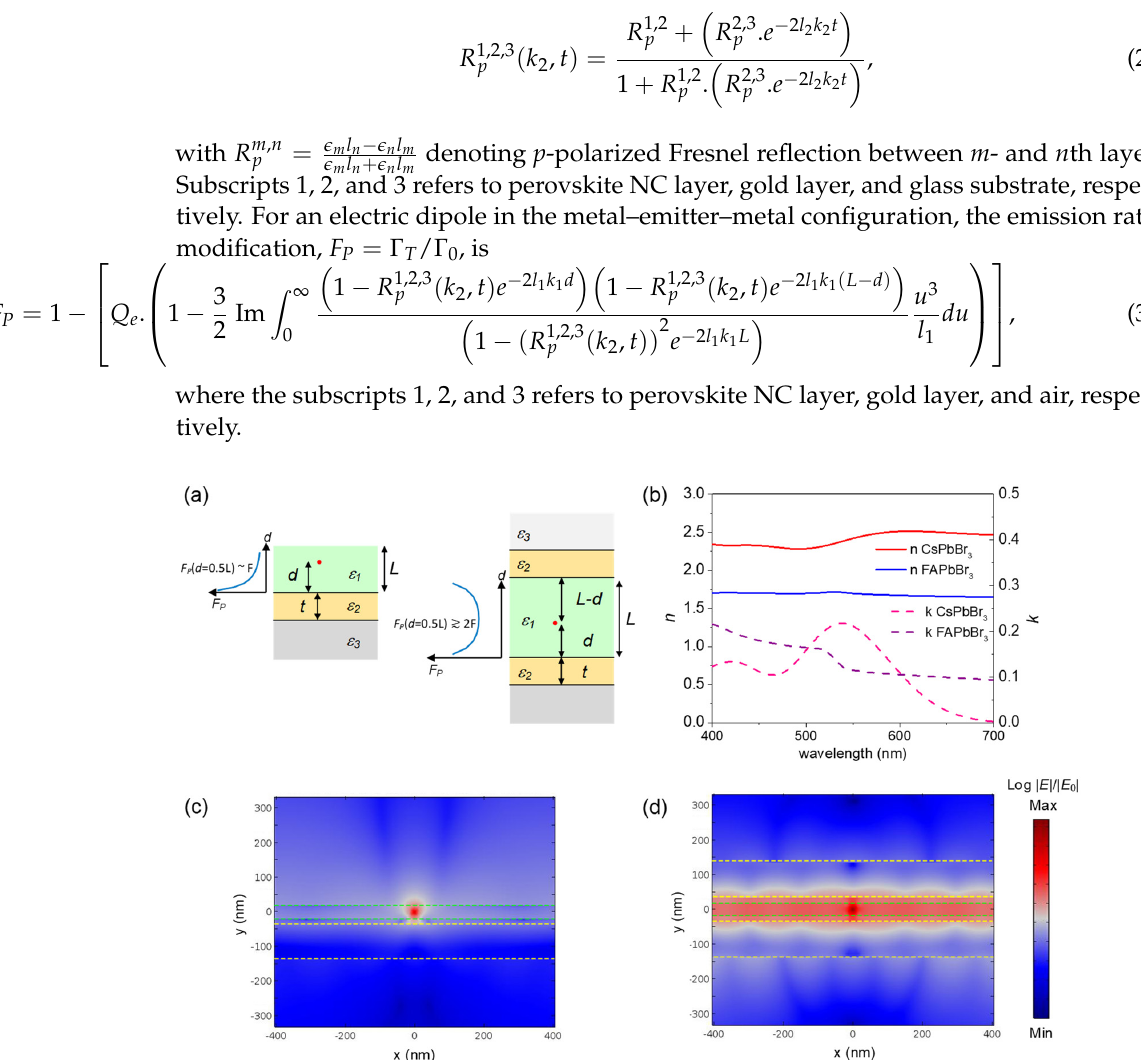
Figure 4. Analytical calculation and electromagnetic simulation approaches to determine the emission rate enhancement: ( a ) Geometry of single and double finite films for analytical calculation and electromagnetic simulation of fluorescence near an interface. Some variables in the scheme are explained in the text. The graphs illustrate the change in spontaneous emission rate enhancement factor ( F P ) over dipole distance from metal surface; ( b ) Experimental optical constants obtained from variable angle spectroscopic ellipsometry for CsPbBr 3 and FAPbBr 3 NC film; Electric field intensity enhancement mapping for a point dipole in the middle of 50 nm thick CsPbBr 3 film ( c ) on the top of one Au-PS layer and ( d ) sandwiched between two Au-PS layers at 540 and 606 nm resonance wavelength, respectively. The structures are indicated by dashed lines.